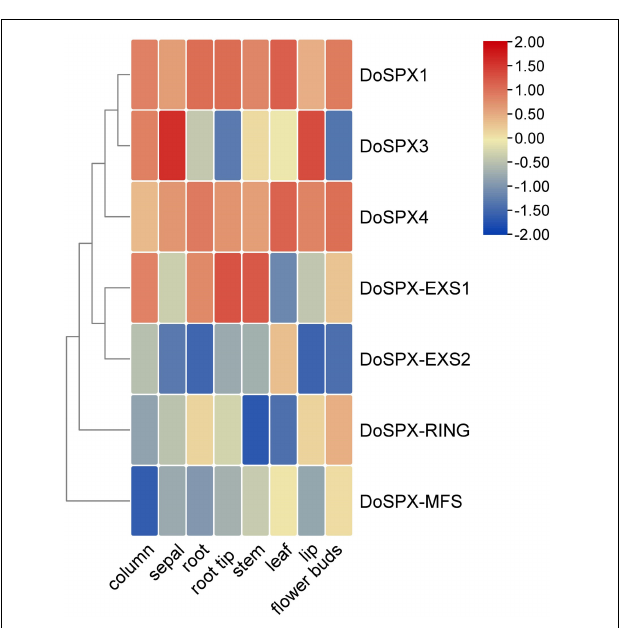
and the isoelectric point was 5.08–9.22. The average hydrophilic coefficient (GRAVY < 0) shows that the other six are hydrophilic proteins except for